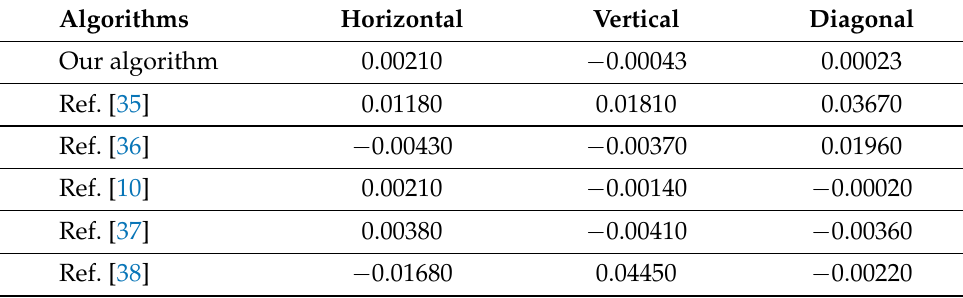
Table 2. Comparison of correlation coefficients of encrypted “Lena.tiff”.